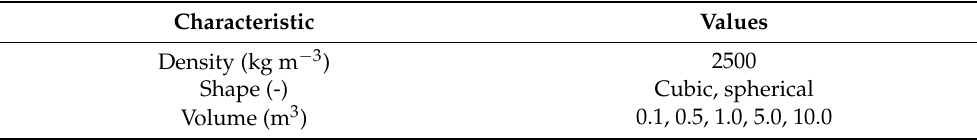
Table 4. Characteristics of the blocks adopted in the parametric